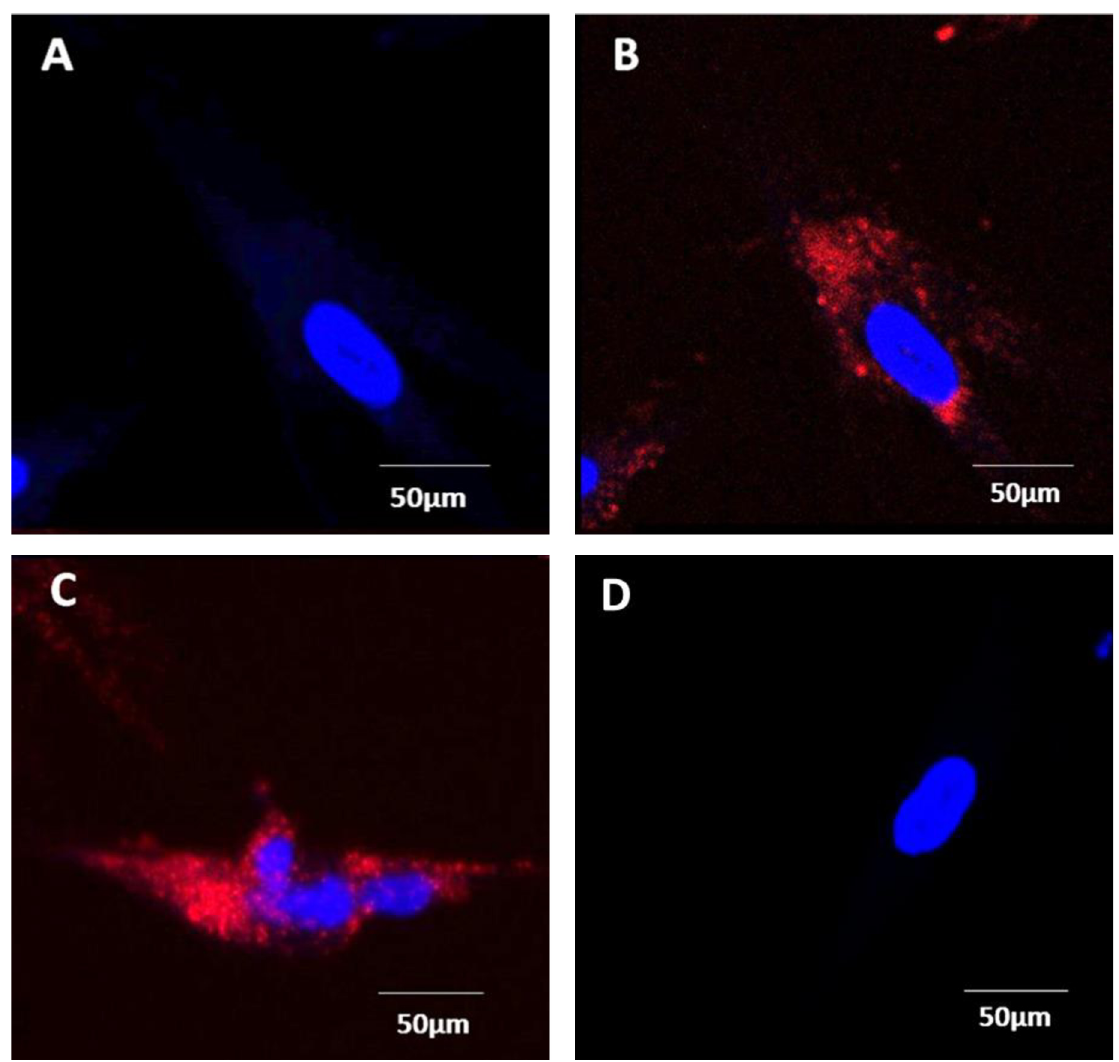
Fig 6. HVSMC (A) loaded with Hoechts live cell nuclear dye (Blue) were incubated with 100nM N/OFQ ATTO594 (B) which bound to the cell surface, with binding of N/OFQ ATTO594 remaining unchanged in HVSMCls treated with 100ng/ml LPS/ PepG for 24 hours. Binding of N/OFQ ATTO594 was prevented by 1 μ M SB-612111 (D). Images are representative of 10 individual cell lines with experiments carried out in